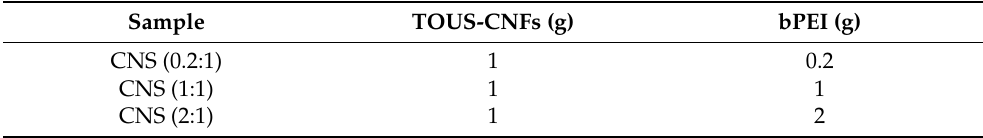
Table 1. List of specimens under investigation and their formulation.